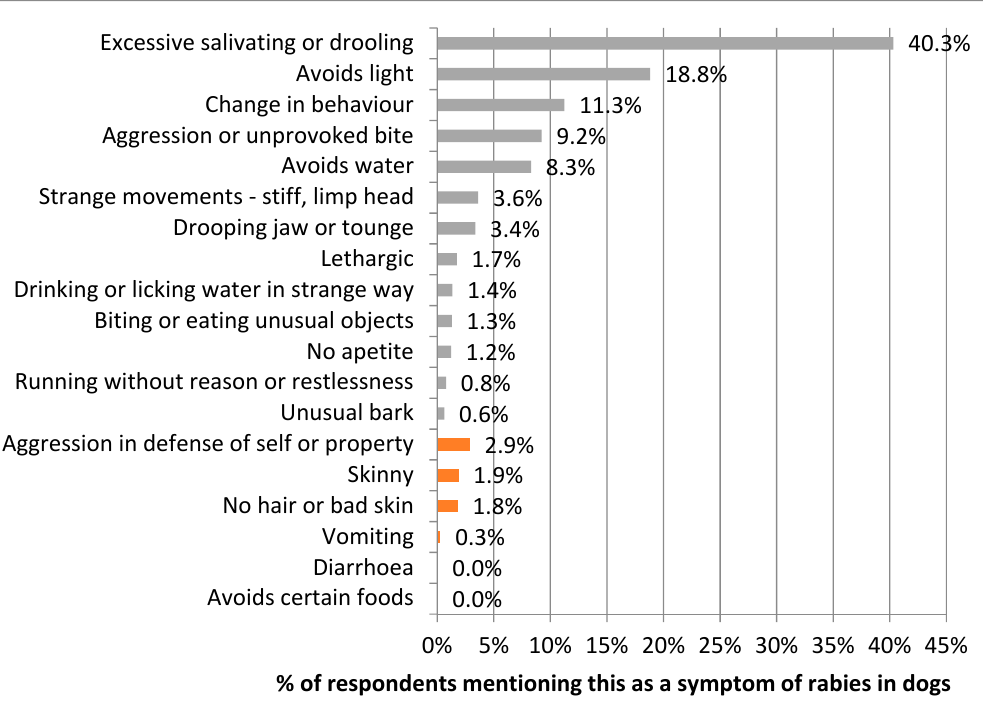
Figure 14. Respondents’ responses to the question of what symptoms are shown by rabid dogs; correct symptoms are in green, incorrect symptoms are in red.